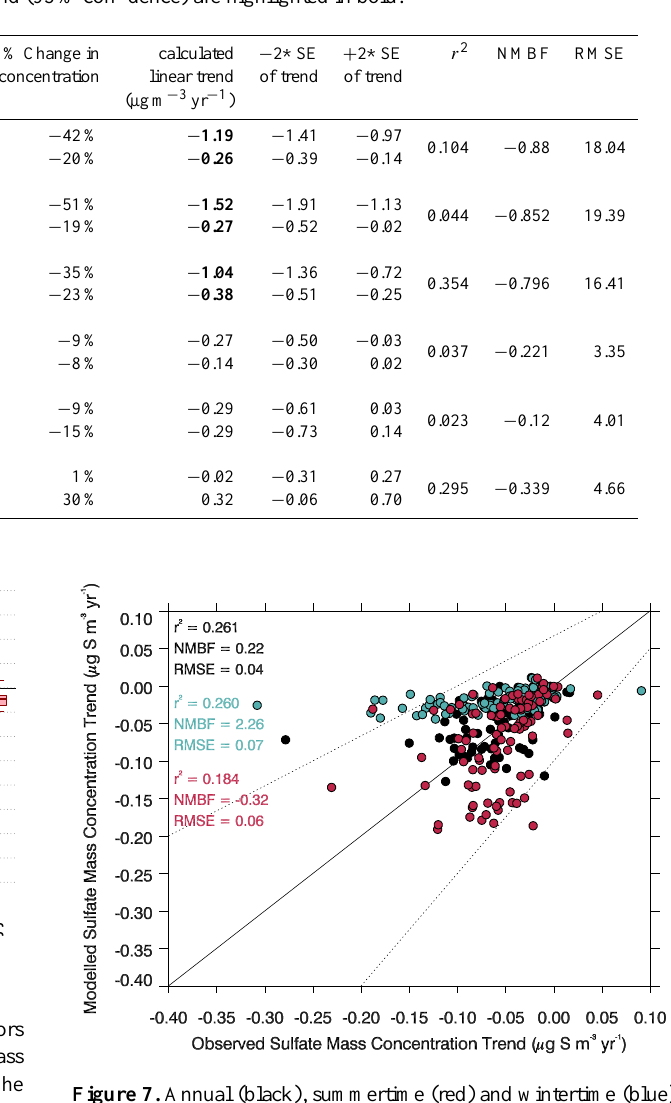
Figure 7. Annual (black), summertime (red) and wintertime (blue) trends in modelled and observed sulfate aerosol mass concentra- tions (µgSm − 3 yr − 1 ) at each individual monitoring location over their operational period between 1978 and